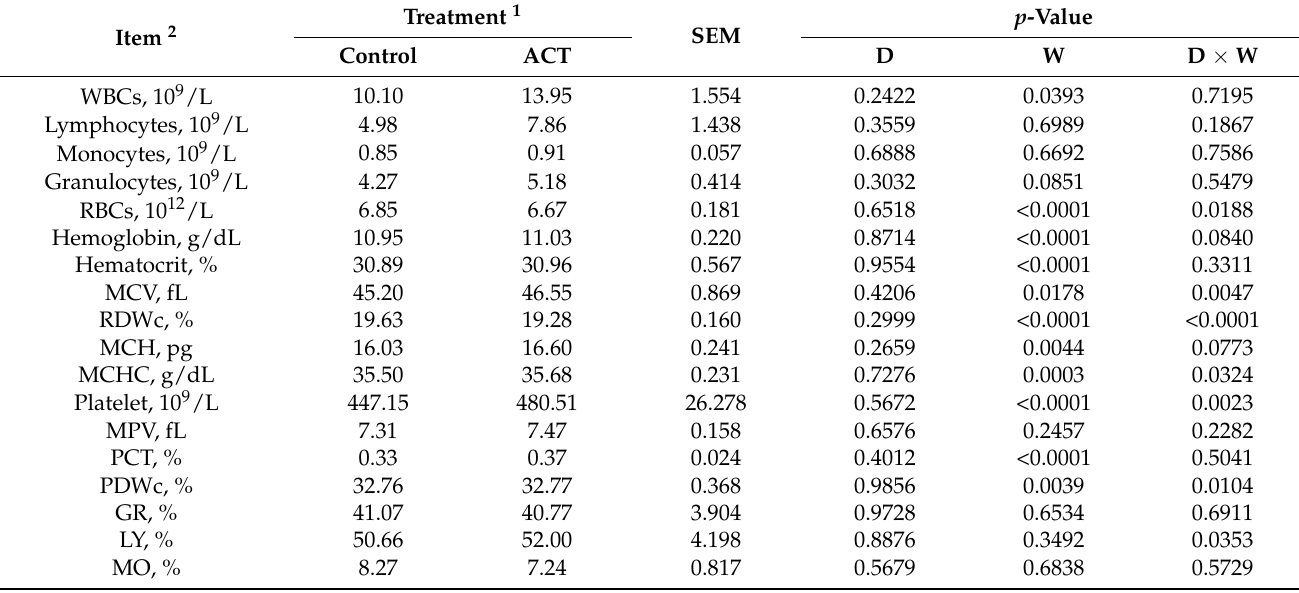
Table 7. Complete blood count analysis of cows postpartum.